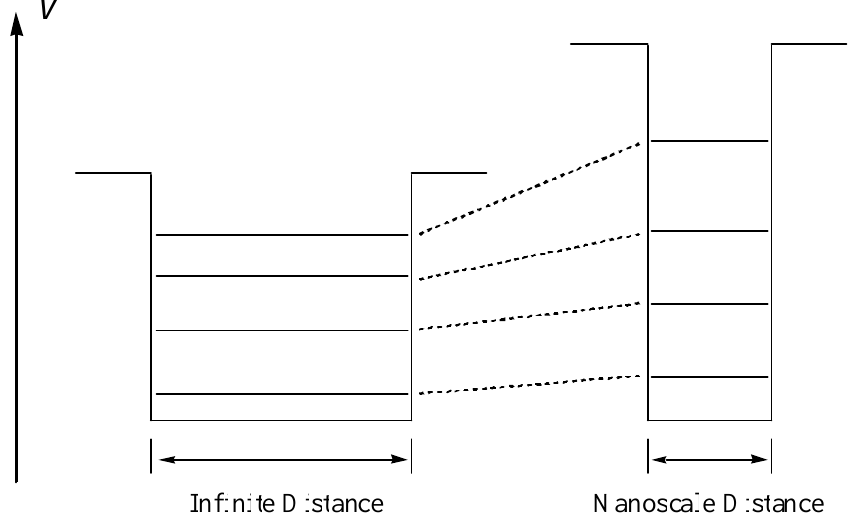
Figure 5: Change of the energy levels of the particle when confining the microscopic particle. On the left-hand side the energy levels for the unconfined system are depicted and on the right-hand side, the corresponding levels for the confined